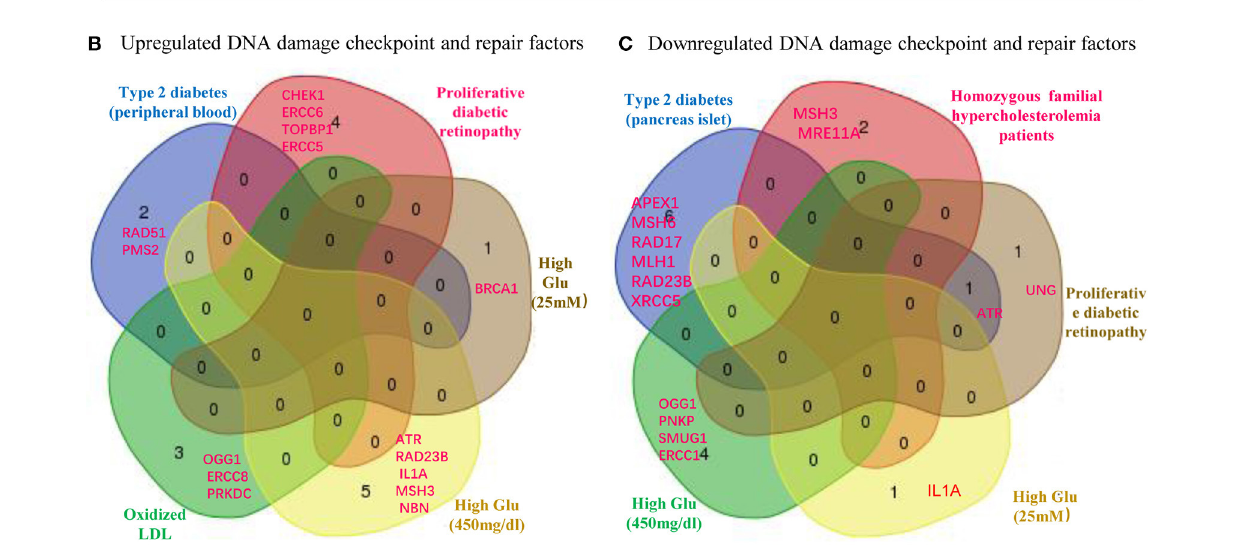
FIGURE 6 | Venn Diagram shows that significantly changed DNA damage checkpoint and repair factor among metabolic diseases and in cells treated with high glucose and oxidized LDL treatment are mostly disease-specific. (A) Almost equal number of DNA damage response factors are induced and attenuated in metabolic diseases. Therefore, a distinct pattern of gene modulation cannot be discerned. (B) Venn diagram of the upregulated DNA damage response factors in different metabolic diseases. (C) Venn diagram of the downregulated DNA damage response factors in different metabolic